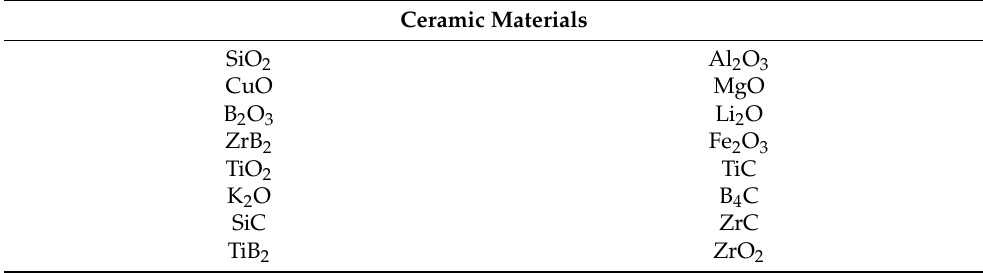
Table 5. Ceramic reinforcement